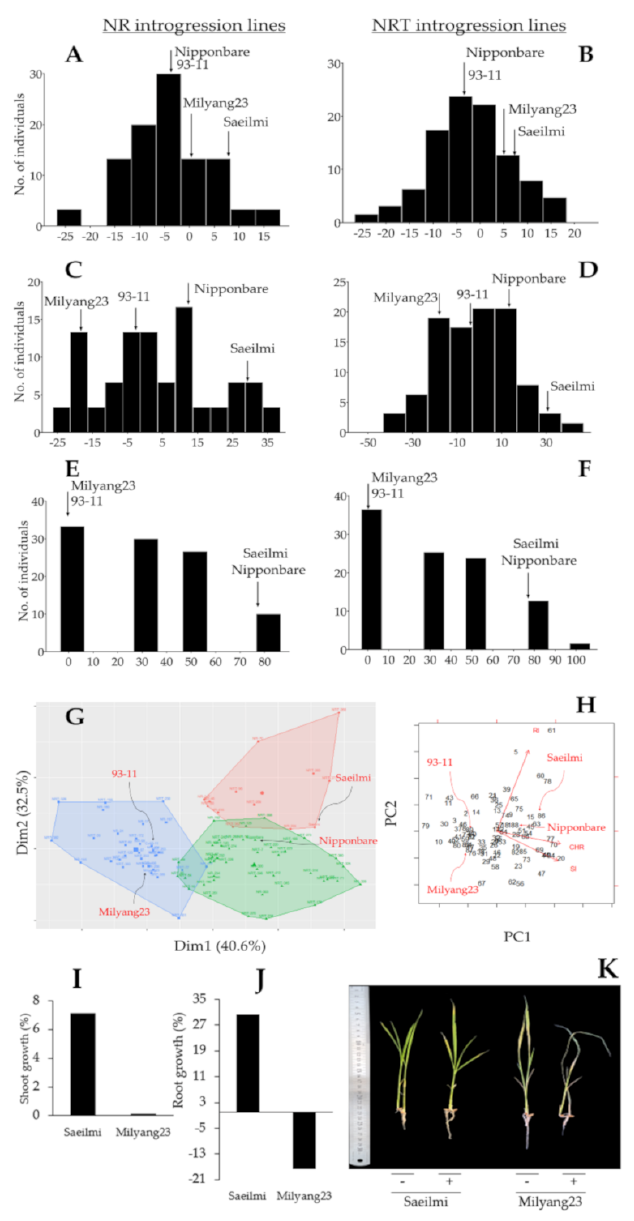
Figure 2. Frequency distribution, clustering, and principal component analysis results. Frequency distribution of the shoot growth of the nitrate reductase (NR, n = 26) ( A ), and nitrate transporter (NRT, n = 59) ( B ) introgression rice lines showing a normal distribution, ( C ) frequency distribution of the roots growth of NR, and ( D ) NRT introgression lines showing a positive skewness and a normal distribution, respectively. ( E ) frequency distribution of the KClO 3 response of NR, ( F ) NRT introgression rice lines showing a positive skewness, ( G ) Clusters showing the distinctive phenotypic response between Saeilmi (P1) and Milyang23 (P2), and that of the NR or NRT introgression lines, and ( H ) 2-D principal component analysis (PCA) indicating the correlation between traits, and ( I – K ) shoot and root growth pattern of Saeilmi (P1) and Milyang23 (P2) in response to KClO 3